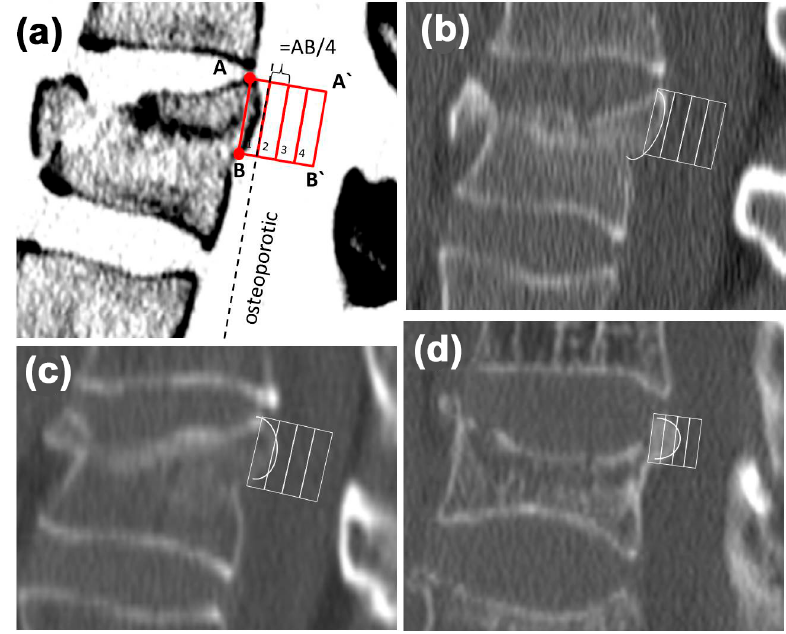
Figure 1. Classification of the degree of bulging. ( a ) Schematic picture showing the algorithm: defining the most cranial A and the most caudal B point of the posterior edge fragment, creating a square with the page length of the distance A to B. Subsequently, the square is divided into 4 equal boxes (1 to 4). ( b ) Sagittal reconstruction of a non-osteoporotic (box 1) traumatic vertebral fracture. ( c ) and ( d ) Sagittal reconstructions of osteoporotic traumatic vertebral fractures reaching box 2 and 3.